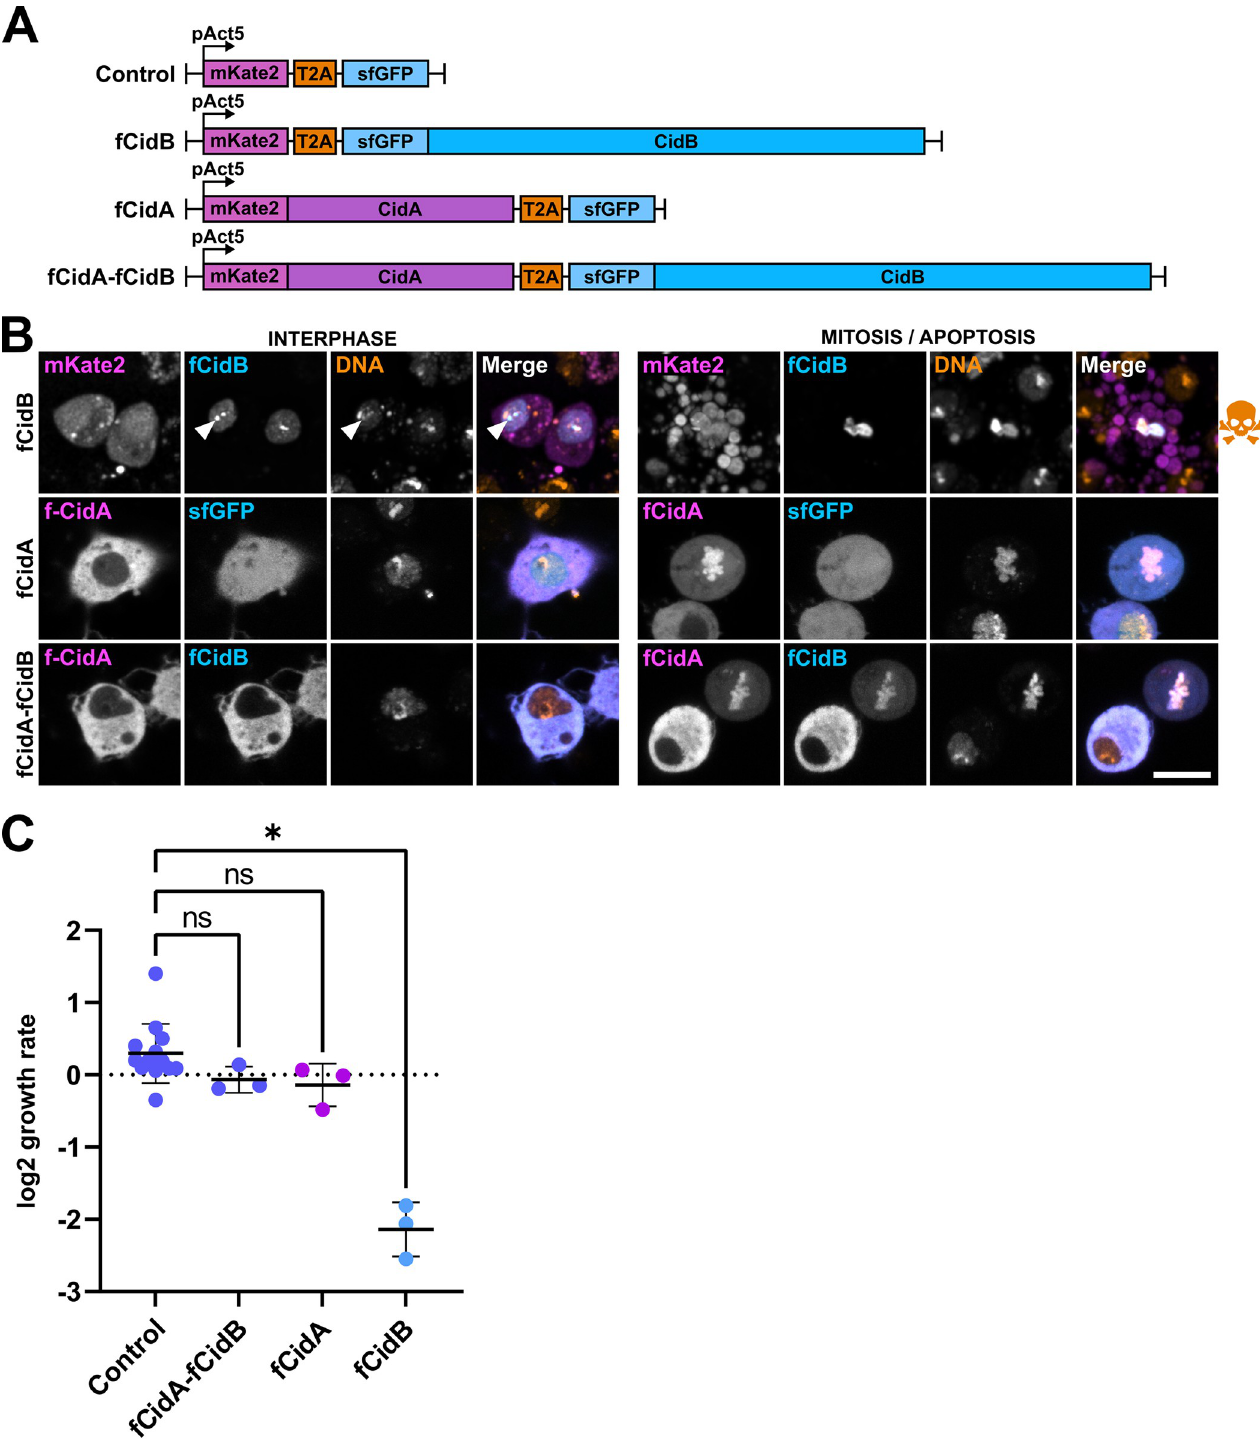
Fig 1. CidA_IV( δ /1) and CidB_IV(a/2) function as a Toxin-Antidote system in S2R+ cells. (A) Schematic drawing of the constructs used to express fCidA and fCidB and in FACS analyses. Fluorescent effectors expressed alone are co-expressed with an additional free fluorochrome, mKate2 or superfolder GFP thanks to the T2A self-cleaving peptide, all under control of the constitutive promoter of D . melanogaster Actine 5C. All Cid mutants expressed as fluorescent proteins presented in this study are derived from these constructs. (B) Confocal images of transfected cells expressing fCidA or the free mkate2 in magenta, fCidB or the sfGFP in cyan, and the DNA stained with Hoechst in yellow. The left panel shows cells in interphase, the right panel shows either cells in mitosis